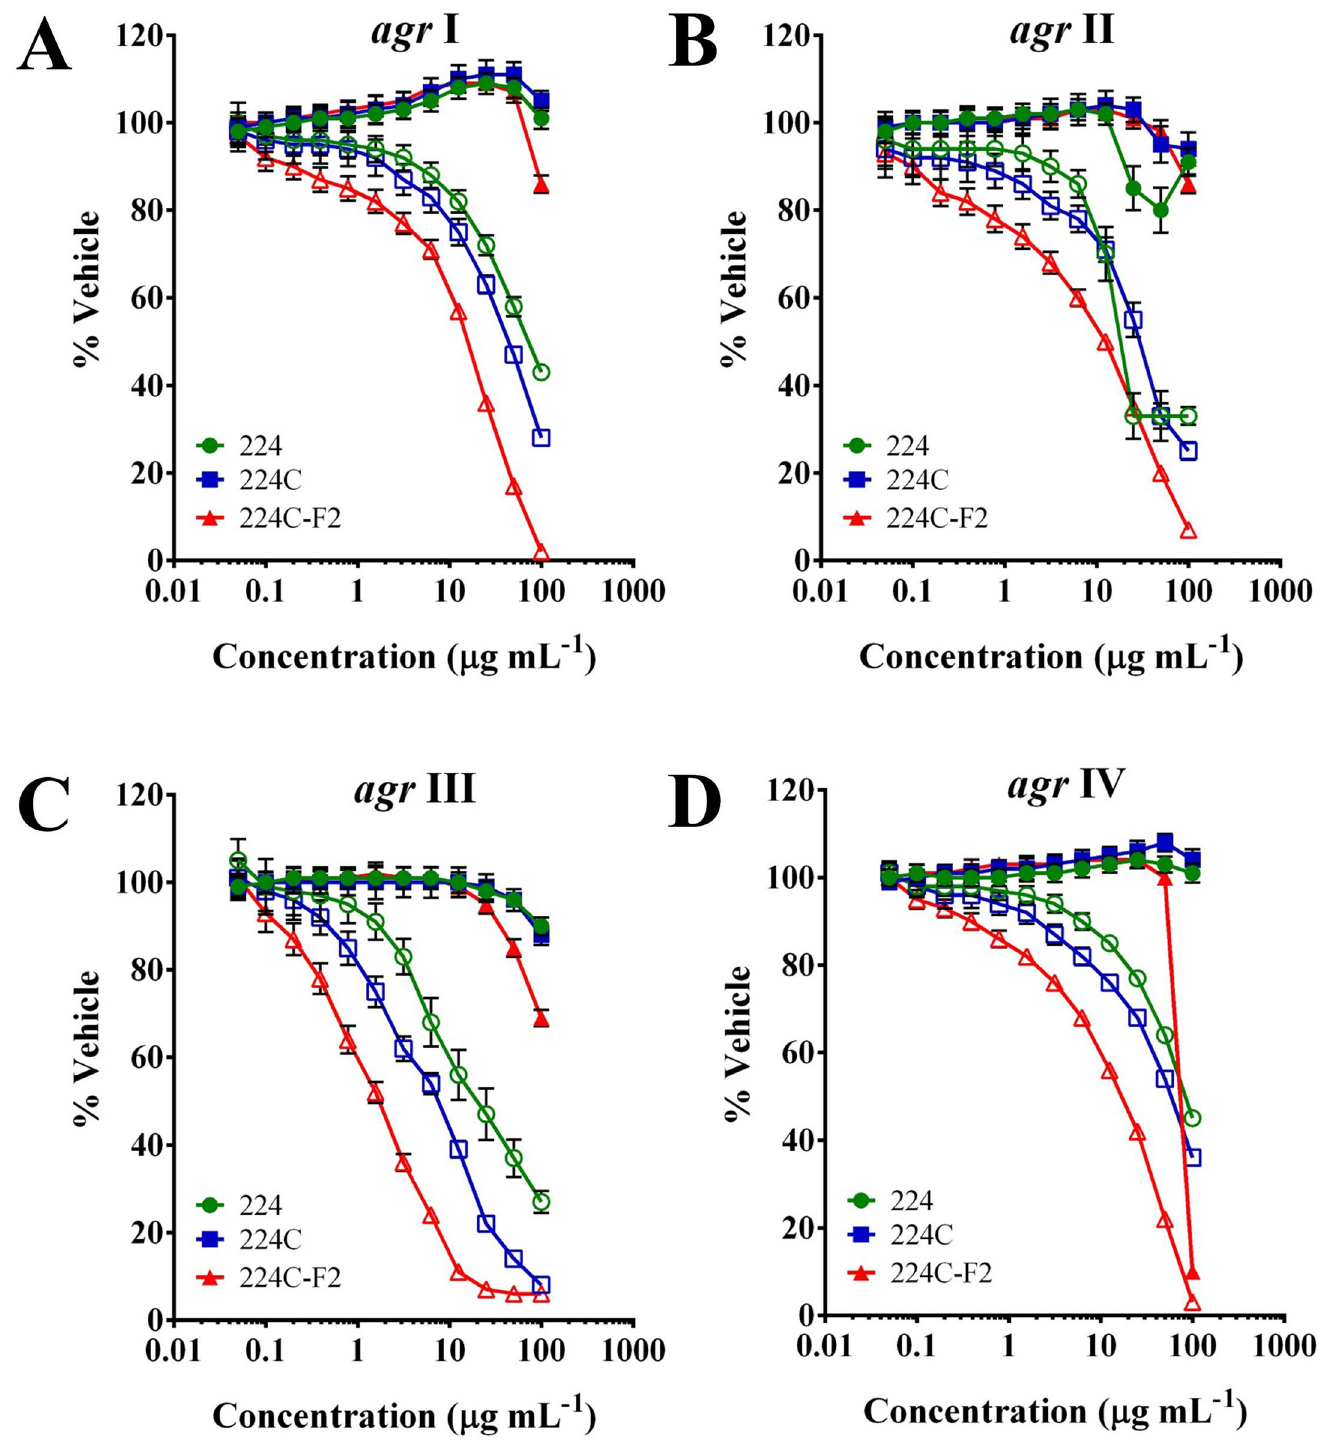
Fig 3. European Chestnut leaf extracts inhibit all four S . aureus agr alleles a non-biocide manner. S . aureus agr reporter strains were treated with extracts 224, 224C, and 224C-F2 at a dose range of 0.05 – 100 μ g mL -1 . Bioactivity guided sequential fractionation resulted in increased quenching of all 4 agr alleles in a manner independent of growth inhibition. Optical density of the culture is represented by solid black symbols; fluorescence in the agr reporters is indicated by the open symbols. The IC 50 and IC 90 for quorum quenching impact of each extract are reported in Table 3. (A) agr I, AH1677; (B) agr II, AH430; (C) agr III, AH1747; (D) agr IV,